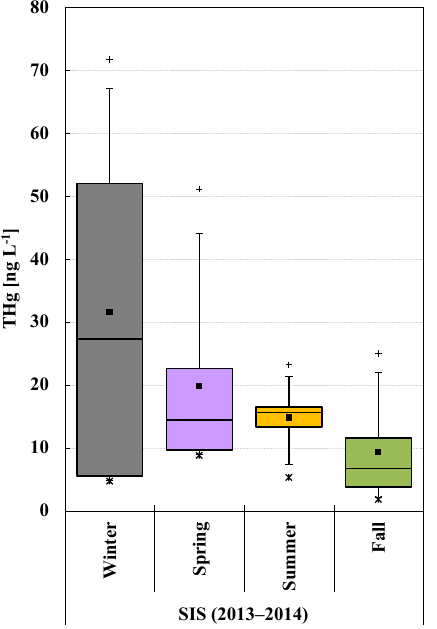
Figure 9. Seasonal distribution of volume-weighted THg concen- tration in precipitation at the tropical GMOS site (Sisal, Mex- ico) in 2013 and 2014. Each box includes the median (midline), mean ( (cid:4) ), 25th and 75th percentiles (box edges), 5th and 95th per- centiles (whiskers), minimum ( ∗ ), and maximum ( + ).